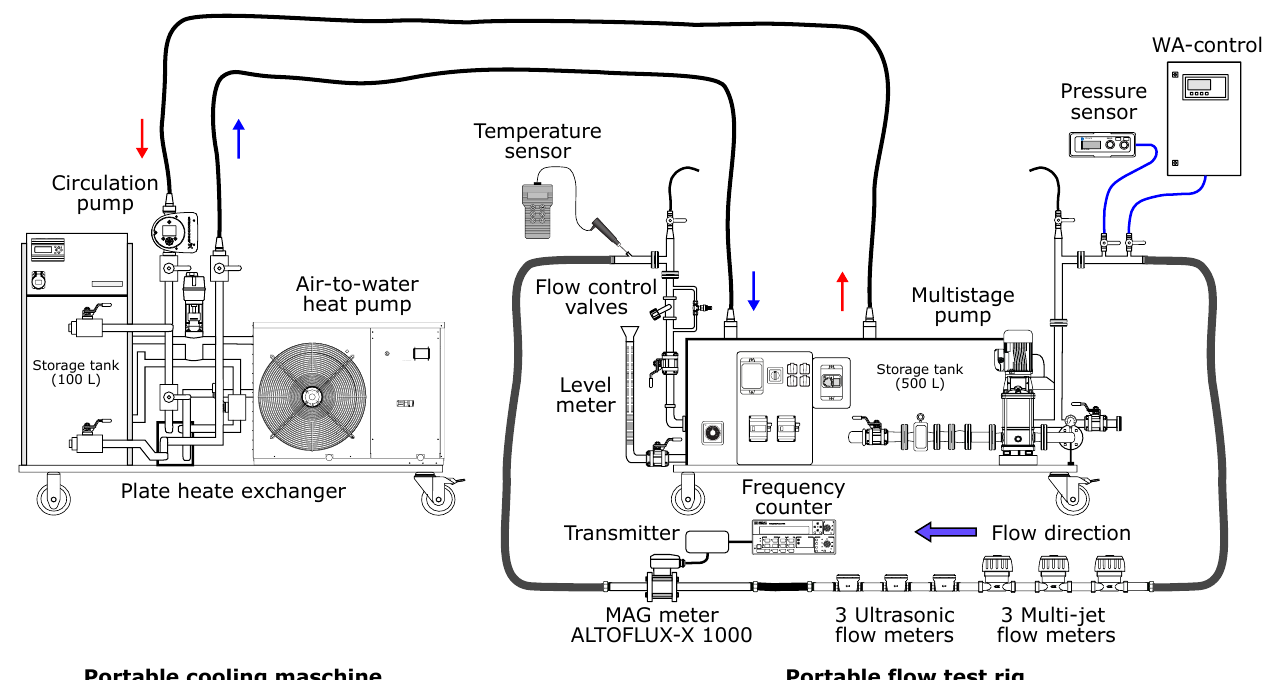
Figure 1. Schematic diagram of the wear test facility. The wear test facility mainly consists of a portable flow test rig and a mobile cooling system to keep the water temperature at a constant low level.